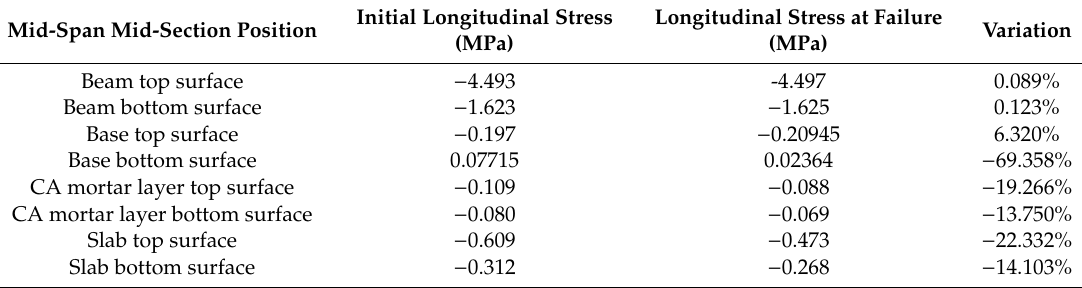
Figure 13. Mid-span load–deflection response curve of the beam under fatigue load. Table 6. Stress variation in structural